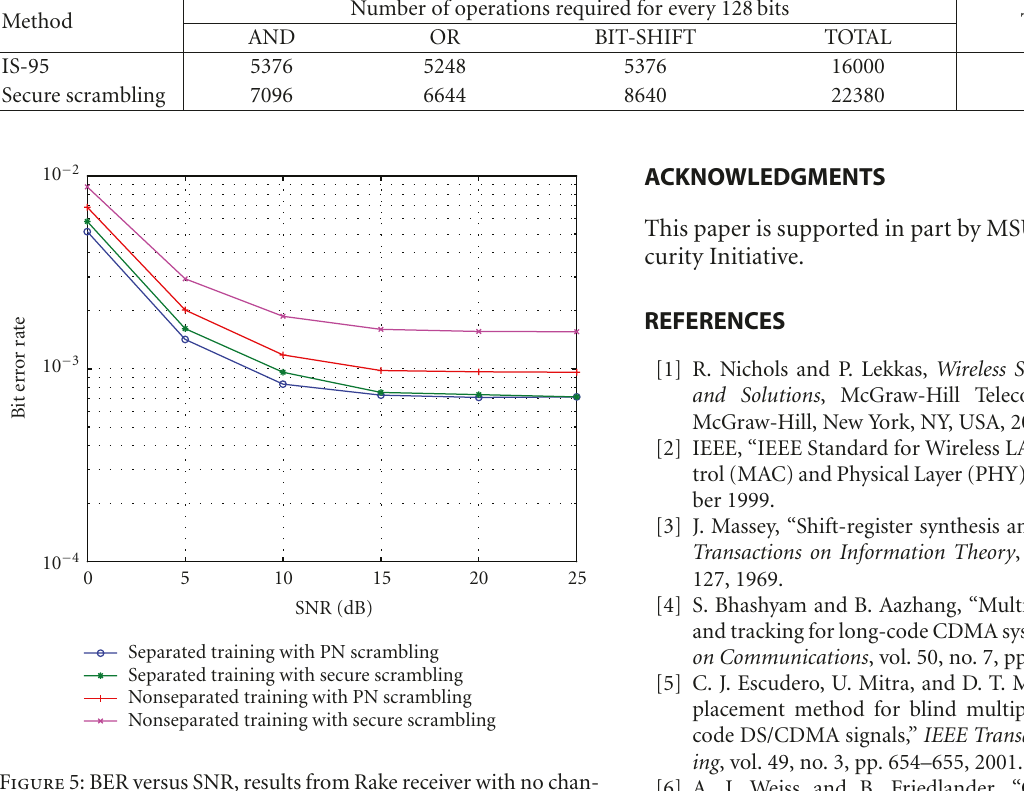
Figure 5: BER versus SNR, results from Rake receiver with no chan- nel coding, 4-ray multipath channel, processing gain N = 16, num- ber of users =